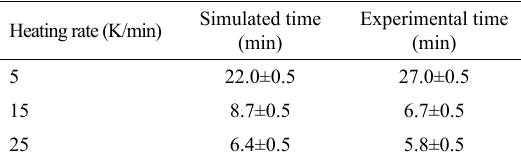
Figure 9: Evolution of the recrystallized fraction as a function of temperature for the nucleation mechanisms of: (a) site saturation, (b) temperature-independent rate, and (c) temperature-dependent rate. Table 5: Evaluation of the recrystallization times, in minutes, based on the simulated and experimental curves in Figure 9 (c), at each heating